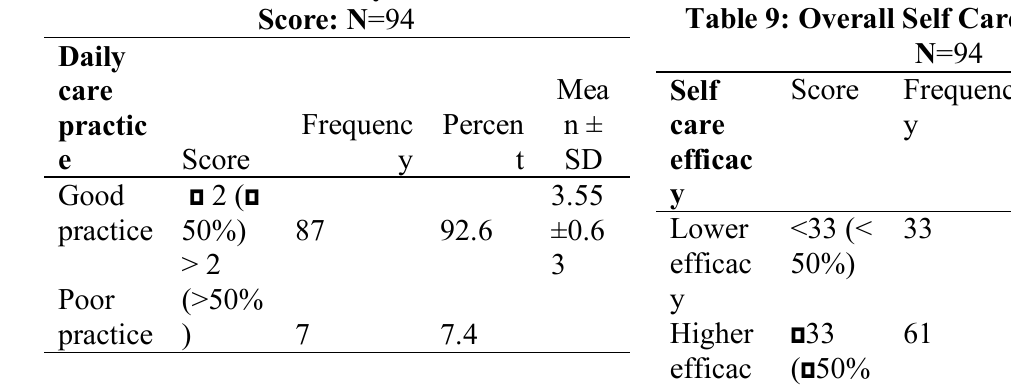
Table 8: Overall Daily Care Practice